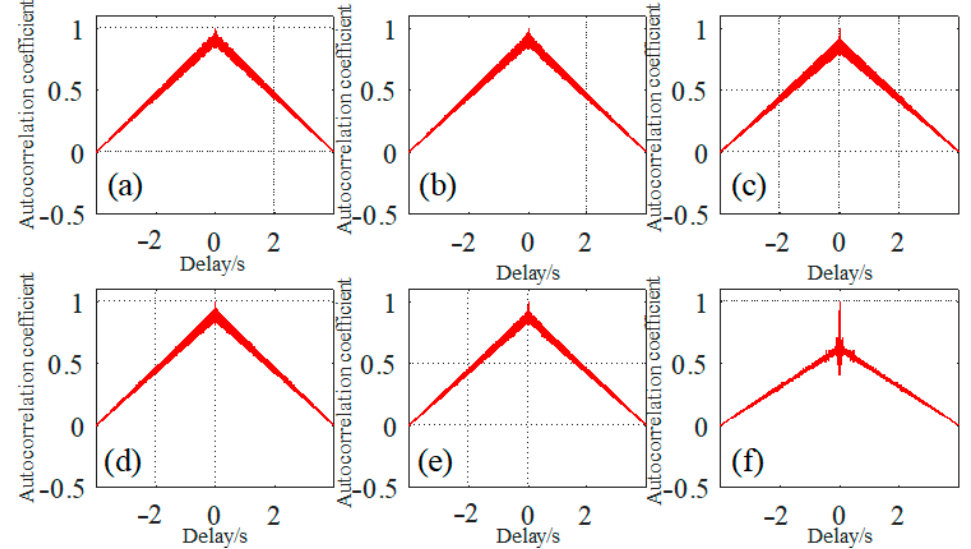
Figure 4. Autocorrelation analysis for different wire rope defect signals: ( a ) for signals from defect 1; ( b ) for signals from defect 2; ( c ) for signals from defect 3; ( d ) for signals from defect 4; ( e ) for signals from defect 5; and ( f ) for signals from defect 6.